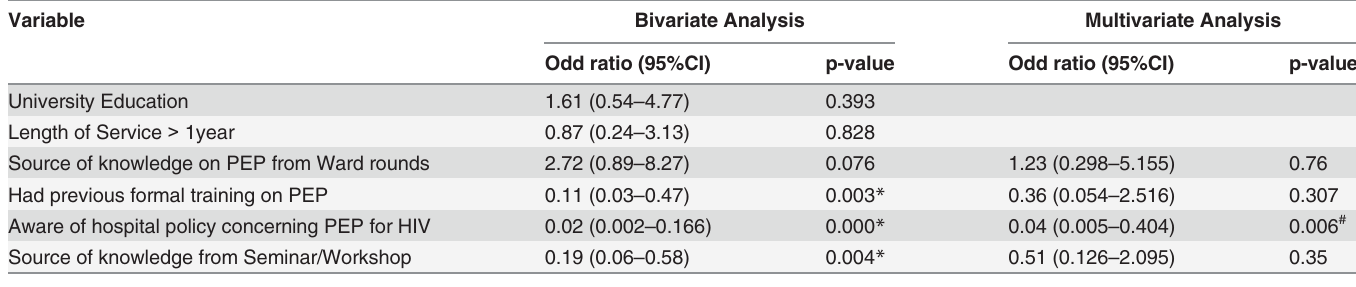
Table 5. Factors associated to Good Knowledge in PEP for HIV among Nurses in Tubah Health District, 2013.